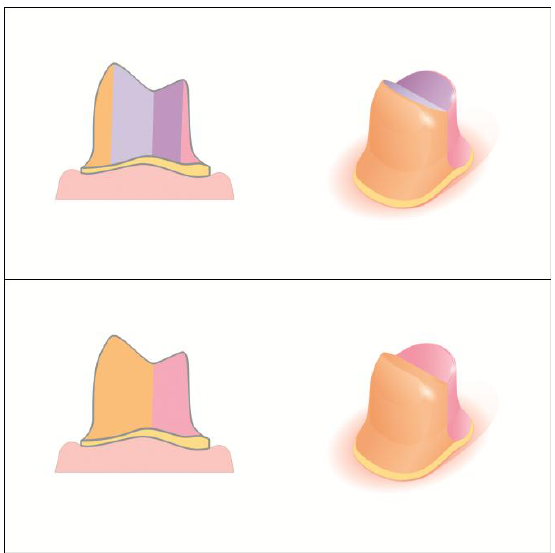
Figure 13. Lower second premolar preparation contour and shape view